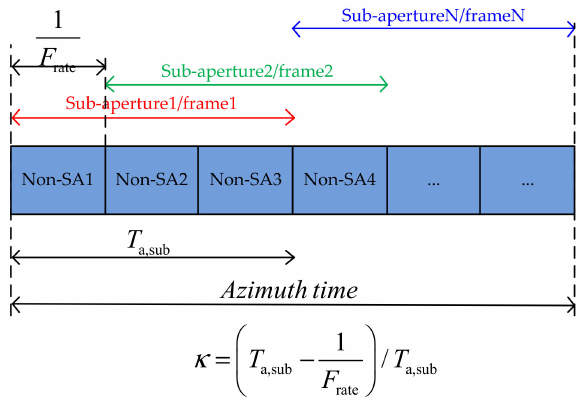
Figure 4. Overlap Frame Rate illustration for